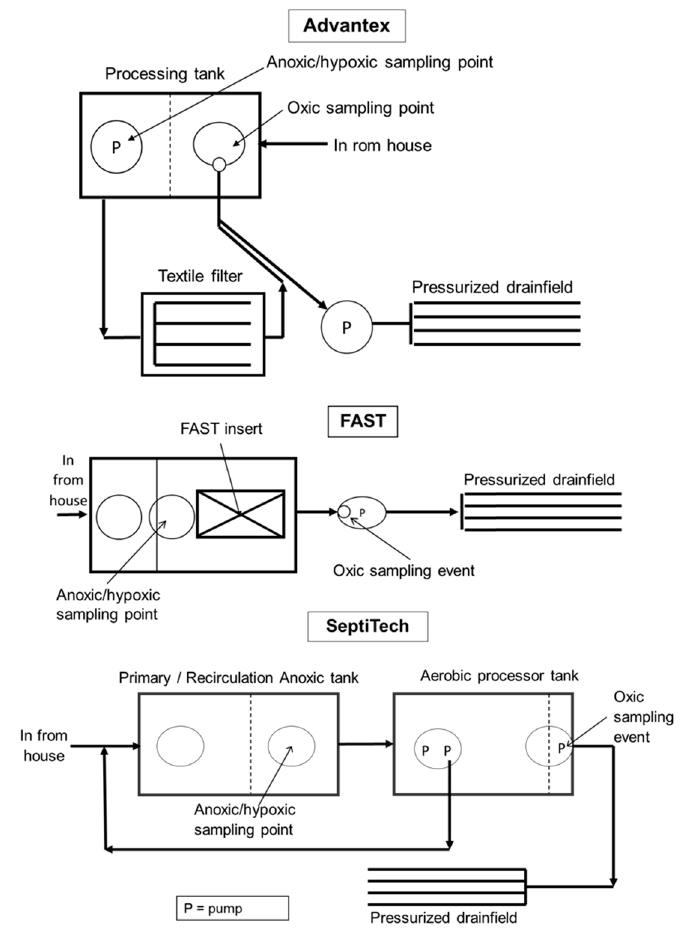
Figure A2. Schematic diagram of Advantex, FAST, and SeptiTech technology treatment trains showing sampling locations. P = pump; SP1 = anoxic component; SP2 = oxic component. Modified from Lancellotti et al. [44].